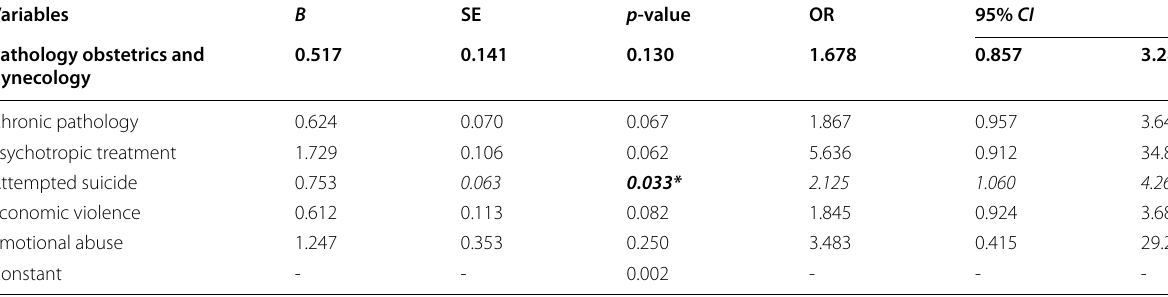
B regression coefficients, SE standard error of the coefficient, OR odds ratio, 95% CI for OR , 95% confidence interval for the odds ratio. * P -value was considered significant if ≤